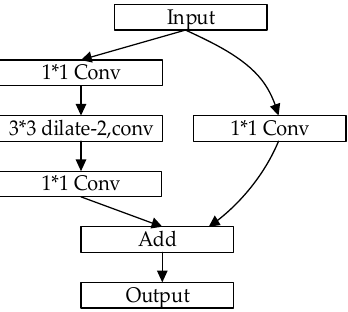
Figure 5. Residual structure of dilated convolution.